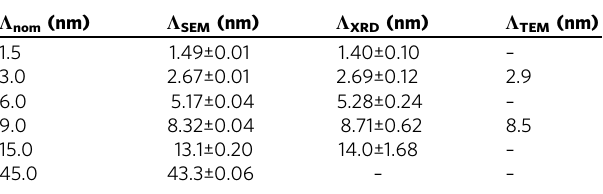
Table 1 Nominal and measured bilayer